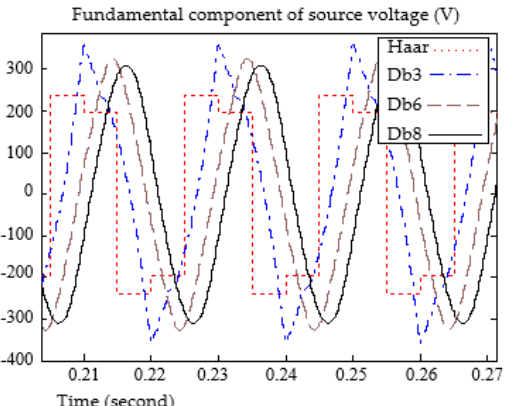
Figure 13. Energies 2016 , 9 , 390